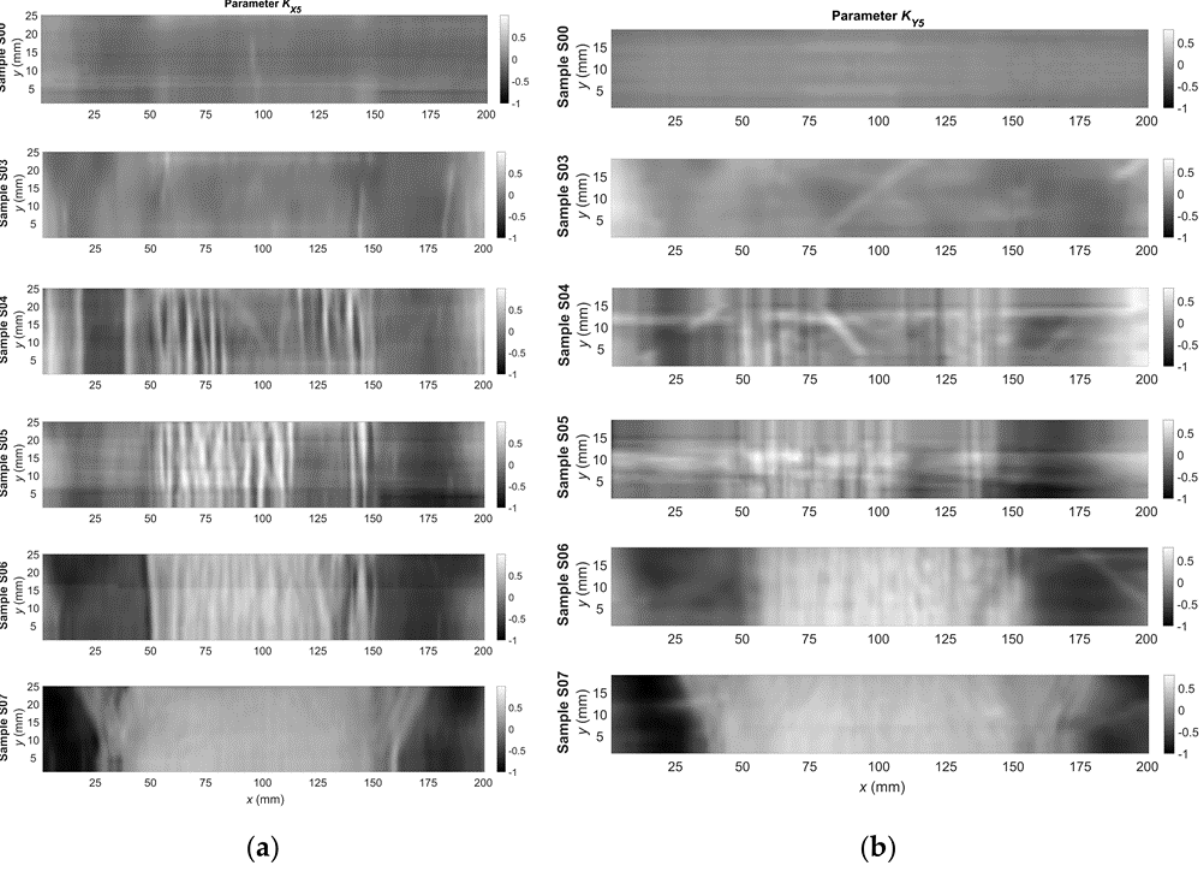
Figure 7. Relative change in the K A 5 parameter as a function of the coordinates of the point from the measurement area for the: ( a ) x -axis direction; and ( b ) y -axis direction.